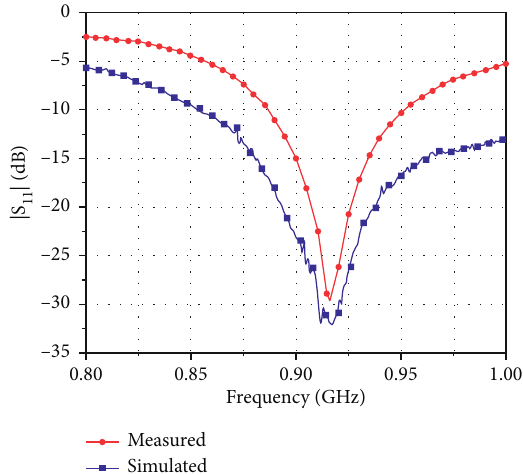
Figure 5: Measured and simulated |S